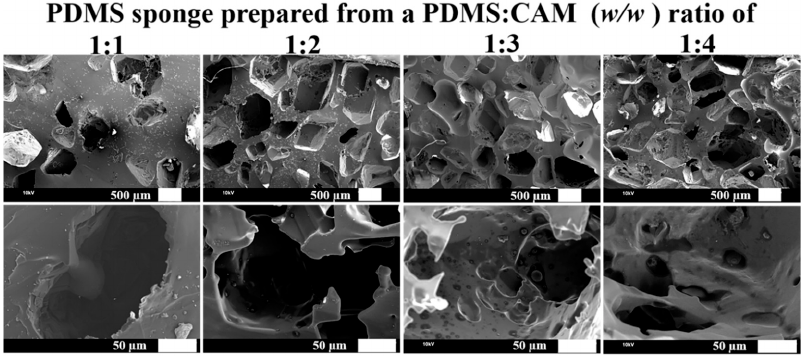
Figure 2. SEM characterization of the PDMS sponge.